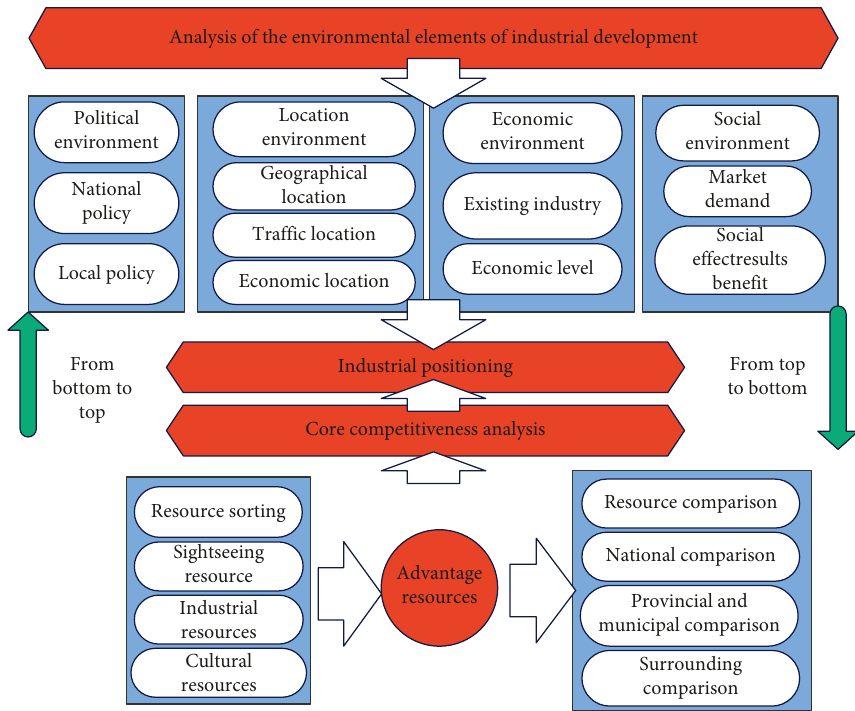
Figure 1: Basic analysis of industry positioning of sports wellness